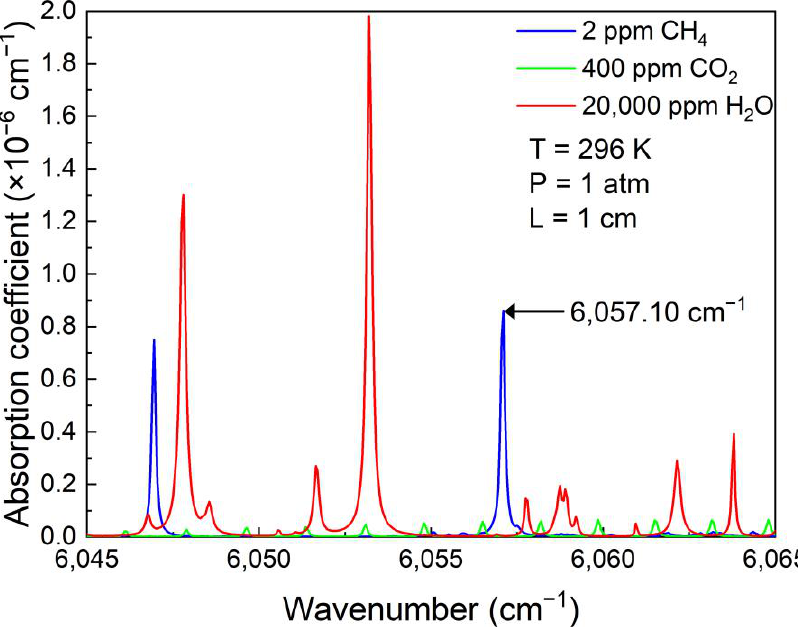
Figure 2. Absorption lines of CH 4 , H 2 O and CO 2 at the conditions of 1 atm pressure, 296 K temper- ature and 1 cm optical absorption length using the database of HITRAN 2016.